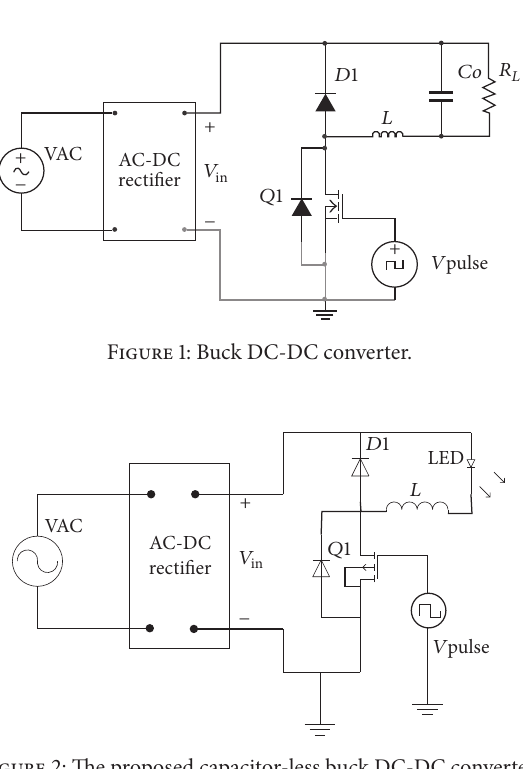
Figure 2: The proposed capacitor-less buck DC-DC converter.